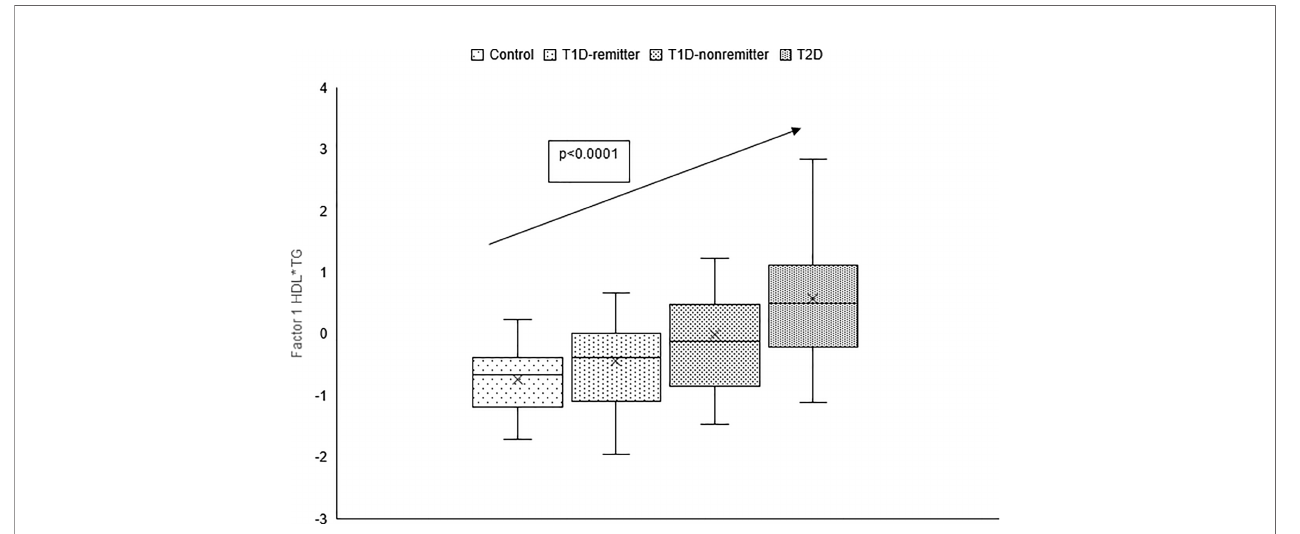
FIGURE 9 | Box plots of the factorial analysis of non-HDL-C, LDL-C, TC, TC/HDL ratio designated as summary factor 1 (TC*LDL) obtained with the factor loading threshold of ≥ 0.45 in 203 adults. Factor 1 explained 90% of the variance in the original lipid parameters with a linear increase in mean composite scores from controls, remitters, non-remitters, and subjects with type 2 diabetes (p=0.0042) (5).